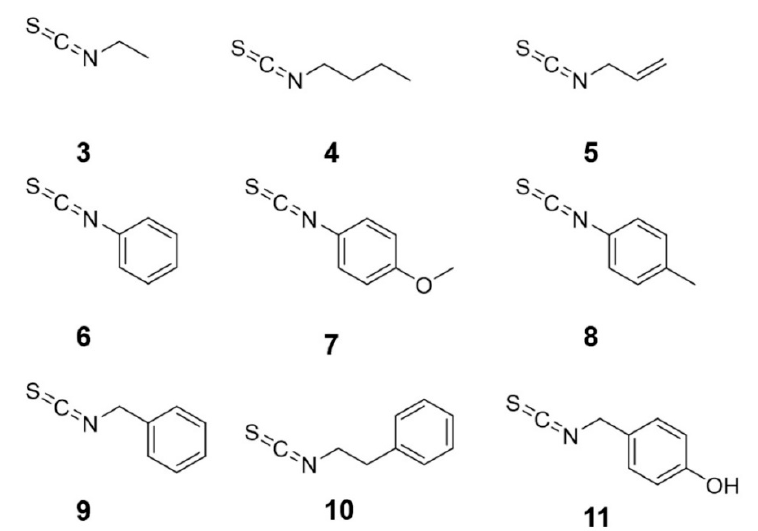
Figure 5. Chemical structures of isothiocyanates (ITCs). 3 , ethyl isothiocyanate, 4 , butyl isothiocyanate, 5 , allyl isothiocyanate, 6 , phenyl isothiocyanate, 7 , 4-methoxyphenyl isothiocyanate, 8 , 4-methylphenyl isothiocyanate, 9 , benzyl isothiocyanate, 10 , phenethyl isothiocyanate, 11 , 4-hydroxybenzyl isothiocyanate.